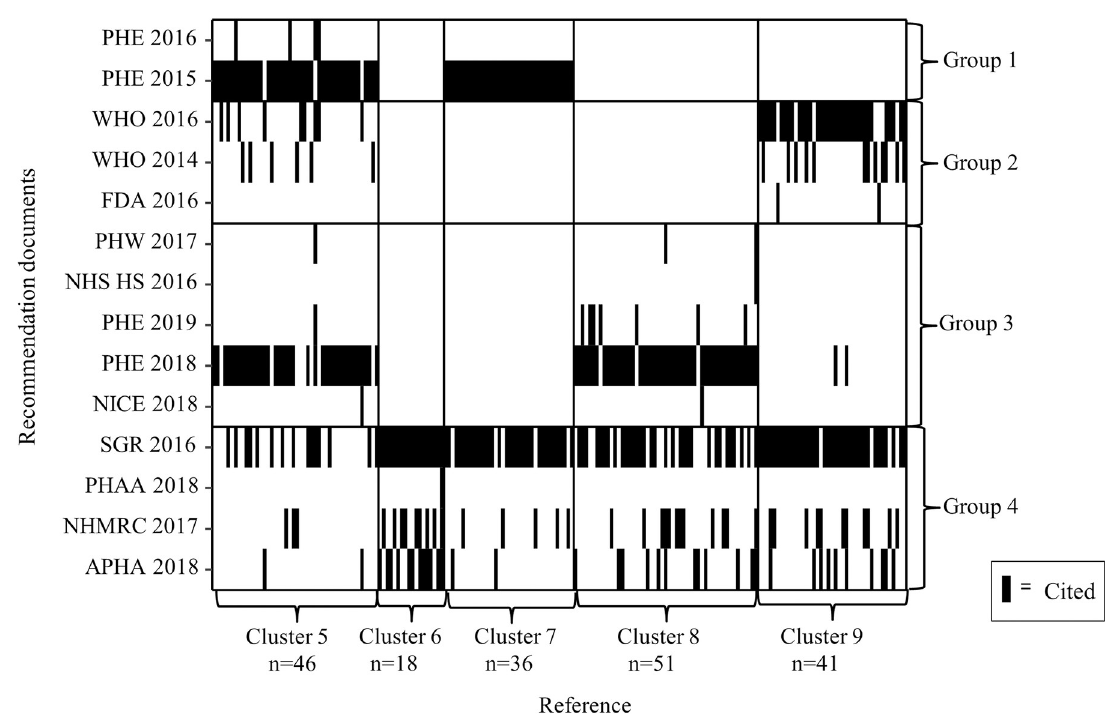
Fig 5. Clustering of recommendation documents by the number of shared references. APHA = American Public Health Association; FDA = U.S. Food and Drug Administration; NHMRC = National Health and Medical Research Council (AUS); NHS HS = NHS Health Scotland; NICE = National Institute for Health and Care Excellence (UK); PHAA = Public Health Association Australia; PHE = Public Health England; PHW = Public Health Wales; SGR = U.S. Department of Health and Human Services: A Report of the Surgeon General.